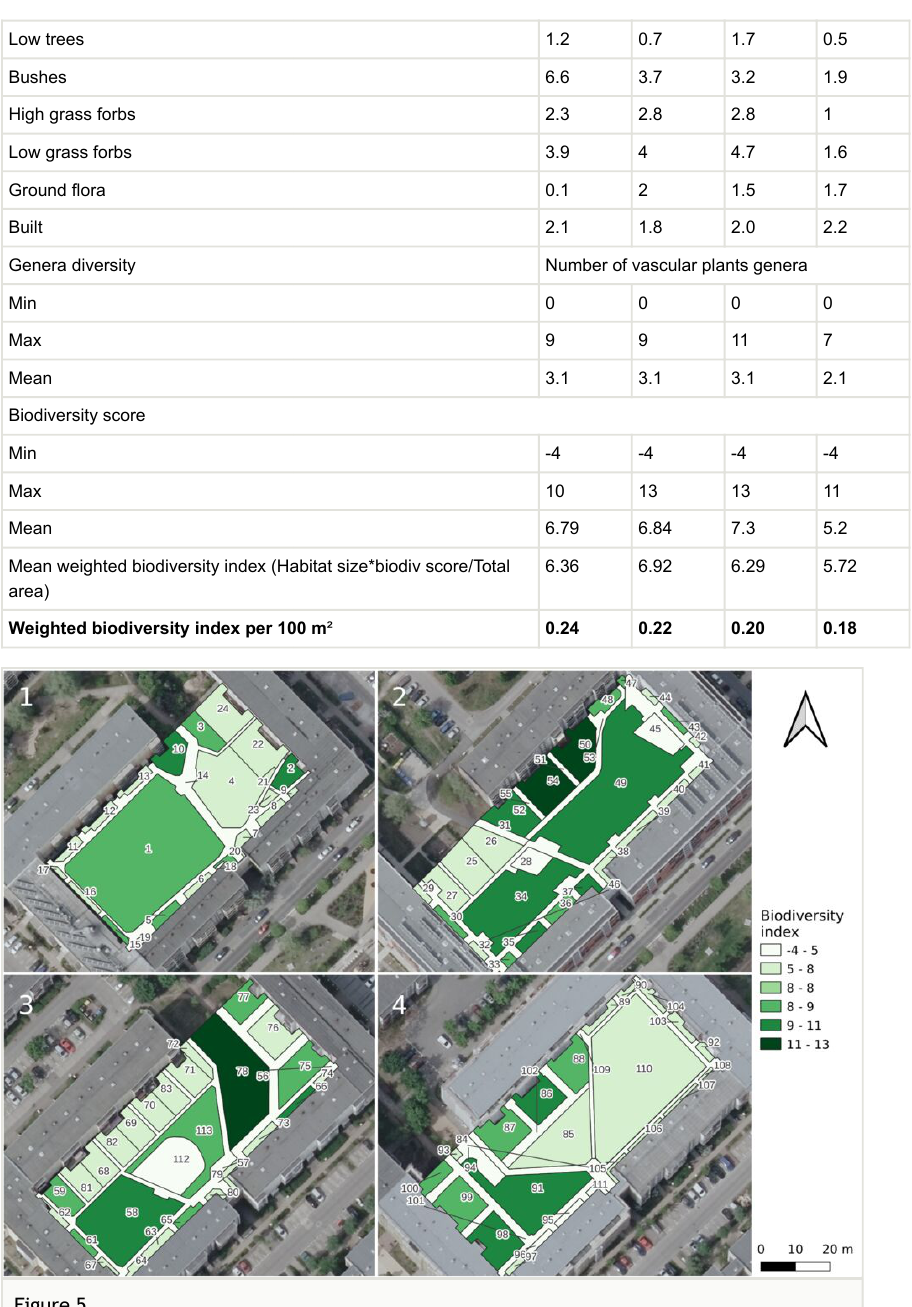
Figure 5. Biotopes and biodiversity scores, based on habitat mapping and biodiversity